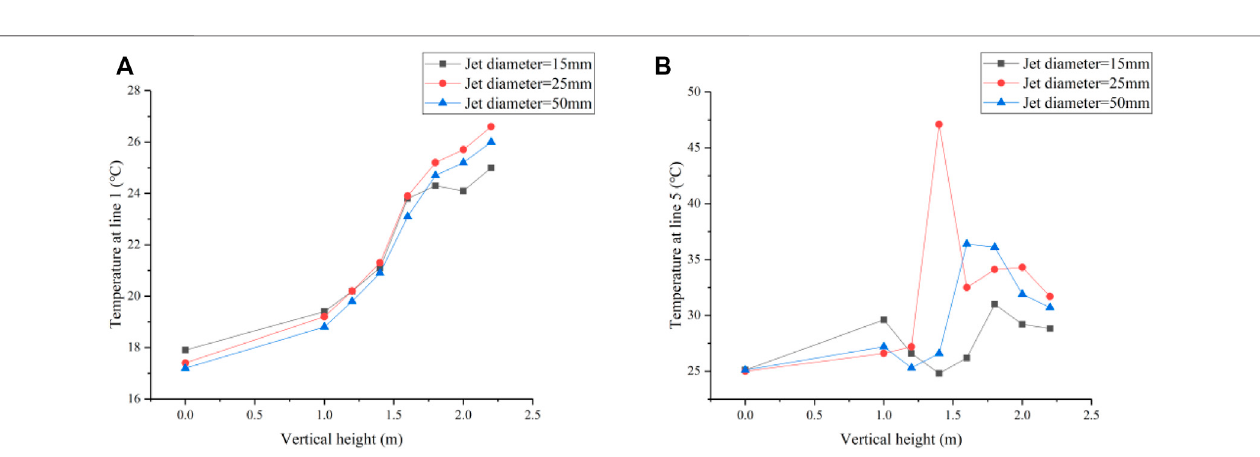
FIGURE 6 | Temperature distribution with height at L1 and L5 under different jet diameters. (A) L1. (B) L5.